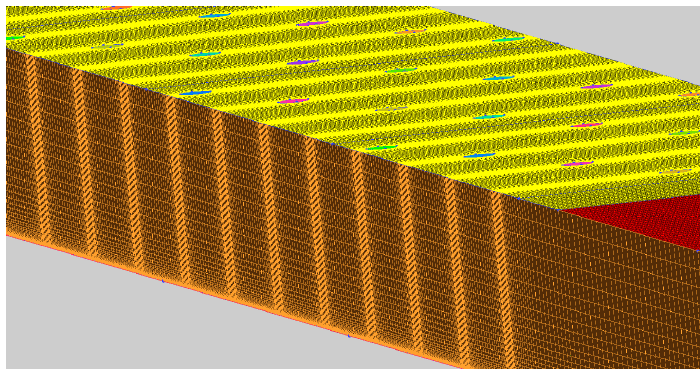
Figure 15. Mesh Figure 15. Mesh detail. Figure 15. Mesh detail.